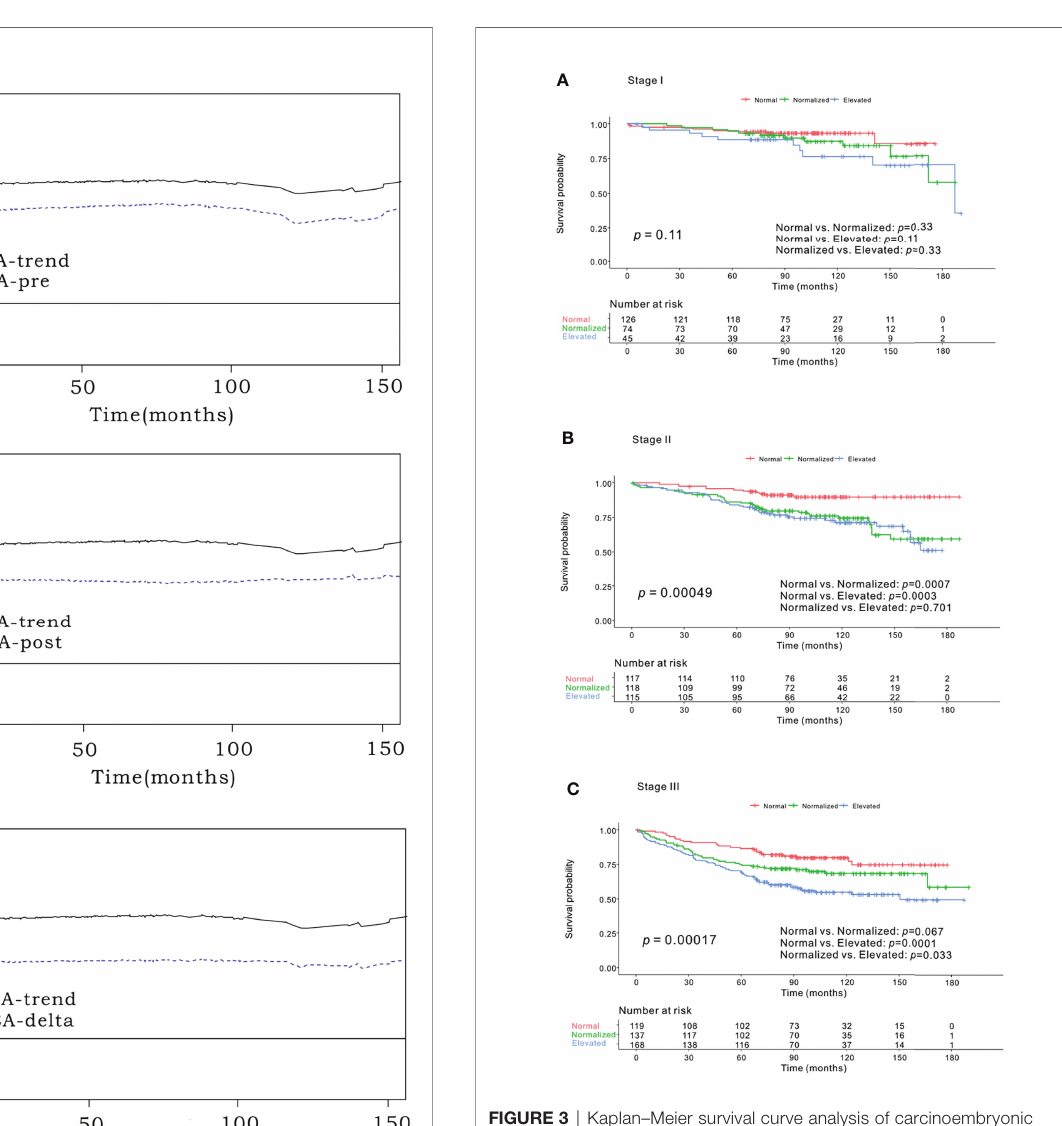
FIGURE 3 | Kaplan – Meier survival curve analysis of carcinoembryonic antigen (CEA)-trend according to colorectal cancer (CRC) stage. (A) Stage I CRC. No signi fi cant distinction in overall survival (OS) was found among the normal, normalized, and elevated groups ( p =.11). (B) Stage II CRC. The normal group had better OS than both the normalized ( p =.0007) and elevated ( p =.0003) groups, although no signi fi cant difference was found in OS between the normalized and elevated groups ( p =.701) ( p =.00049). (C) Stage III CRC. The normal and normalized groups did not show a difference in OS ( p =.067), whereas the normal ( p =.0001) and normalized groups ( p =.033) were associated with better OS than the elevated group ( p